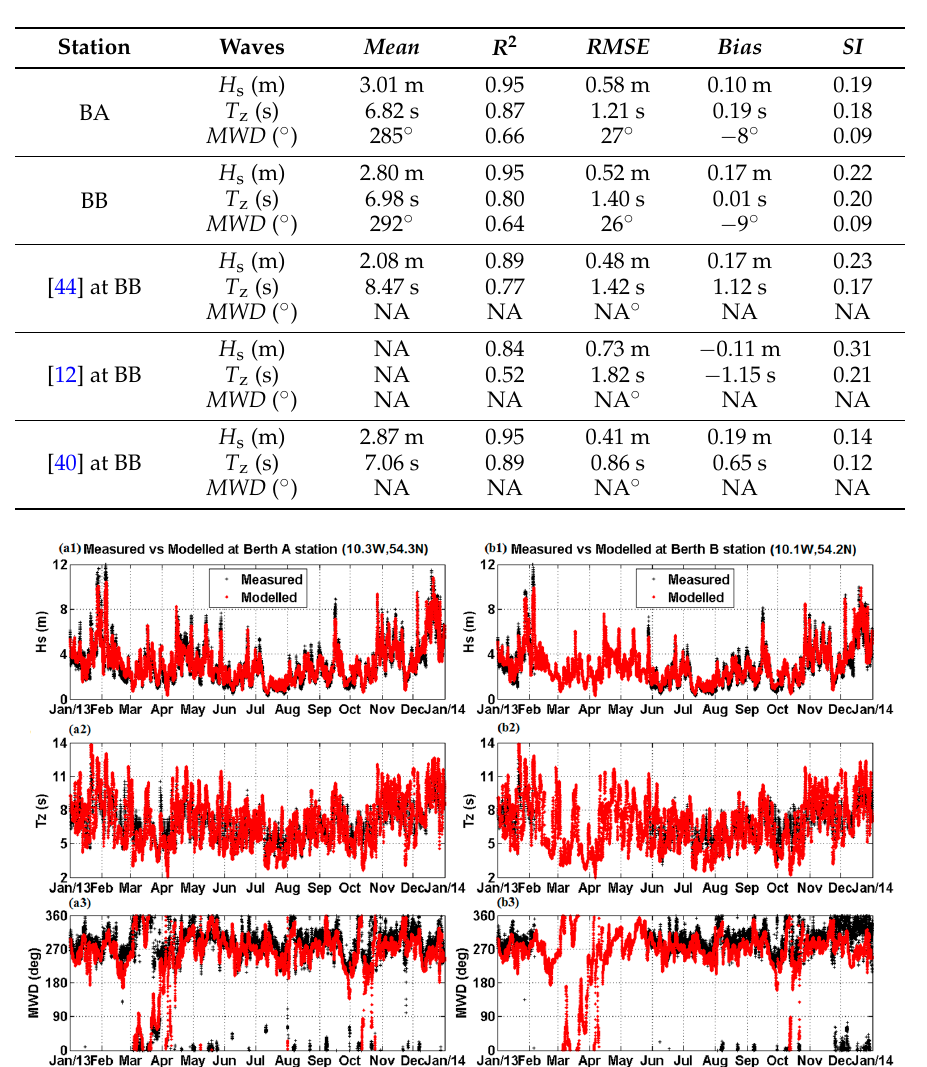
Figure 3. Comparison of modelled and measured H s , T z and MWD at ( a1 – a3 ) BA and ( b1 – b3 ) BB for 2013.